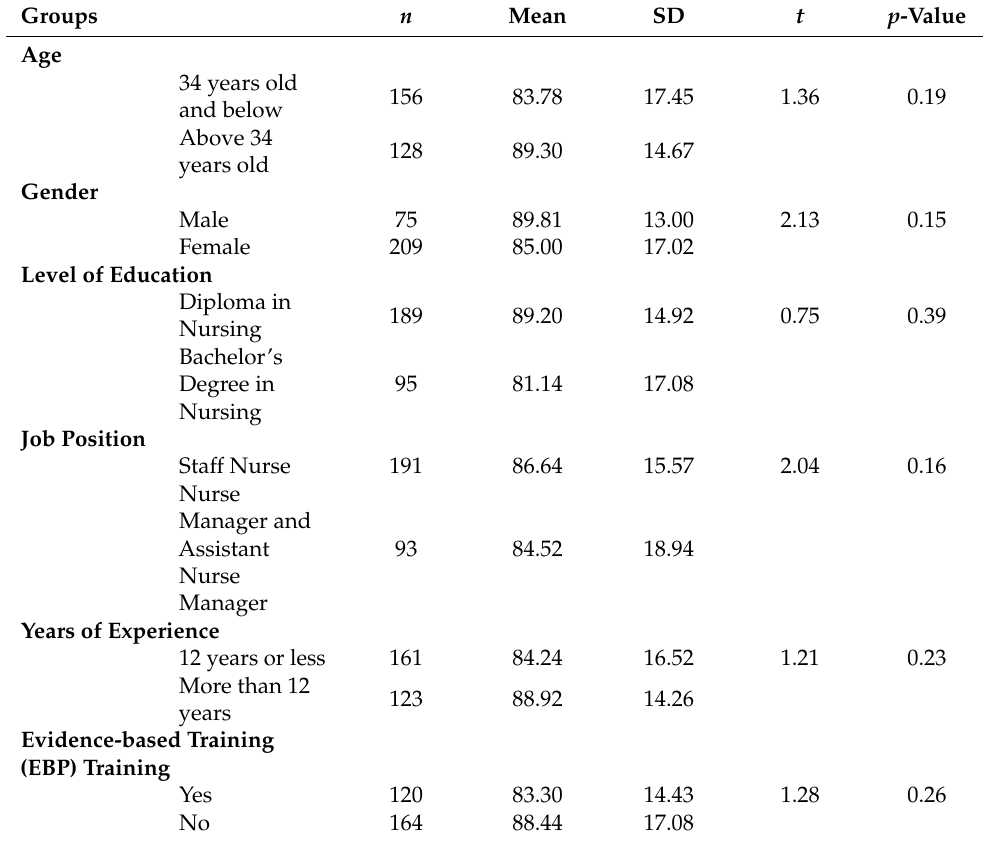
Table 2. Differences of BARRIERS Scale Raw Scores and Nurses’ Demographic Characteristics ( n =